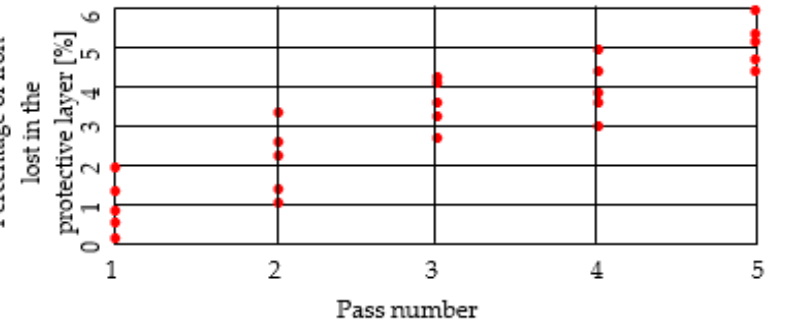
Figure 8. The evolution of Fe percentage lost in the steel wiredrawing process (variant 1 of the protective layer).